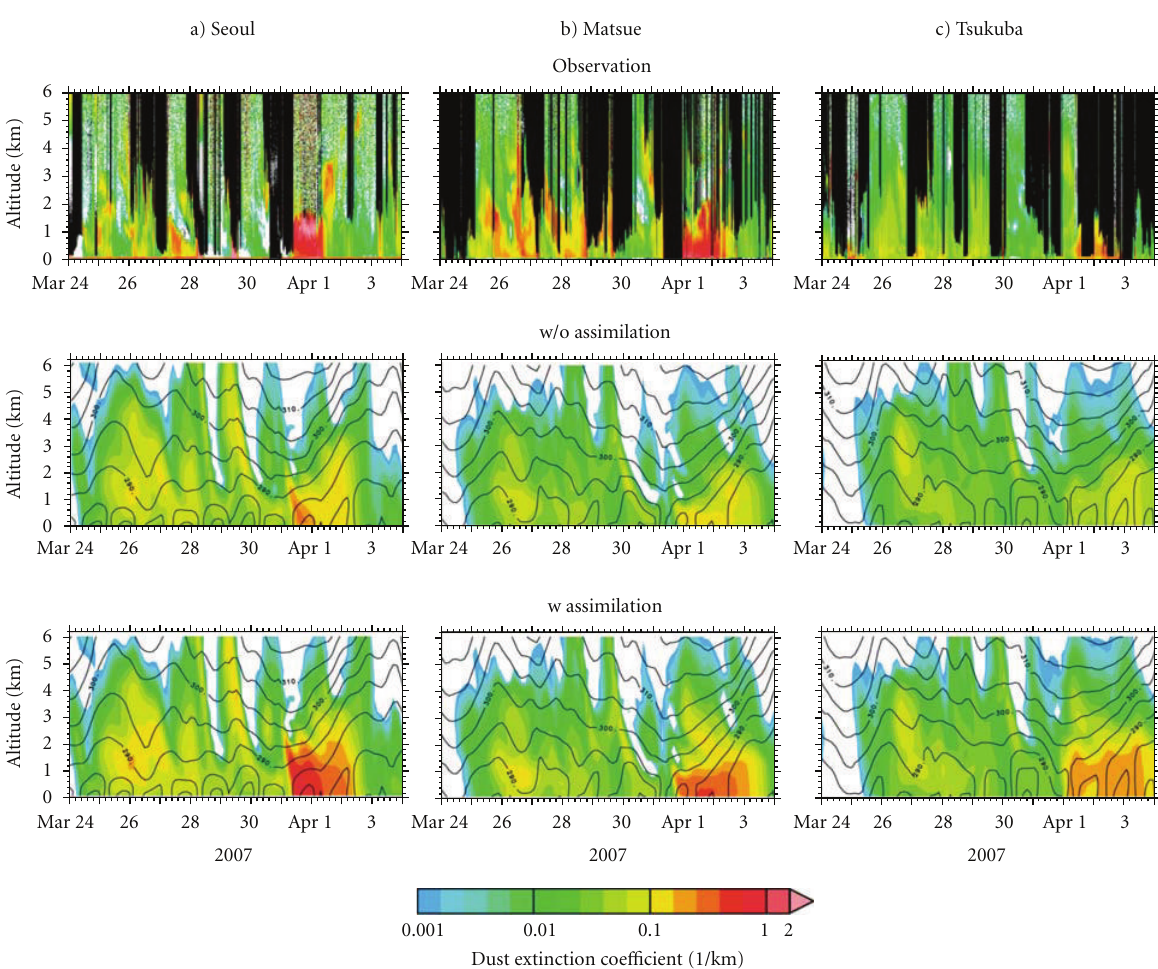
Figure 9: Time-height indications of dust extinction coe ffi cient at Seoul (KR), Matsue (JP), and Tsukuba (JP). The first row shows observa- tion. Second and third rows show modeled dust extinction coe ffi cient without and with data assimilation. Figure from